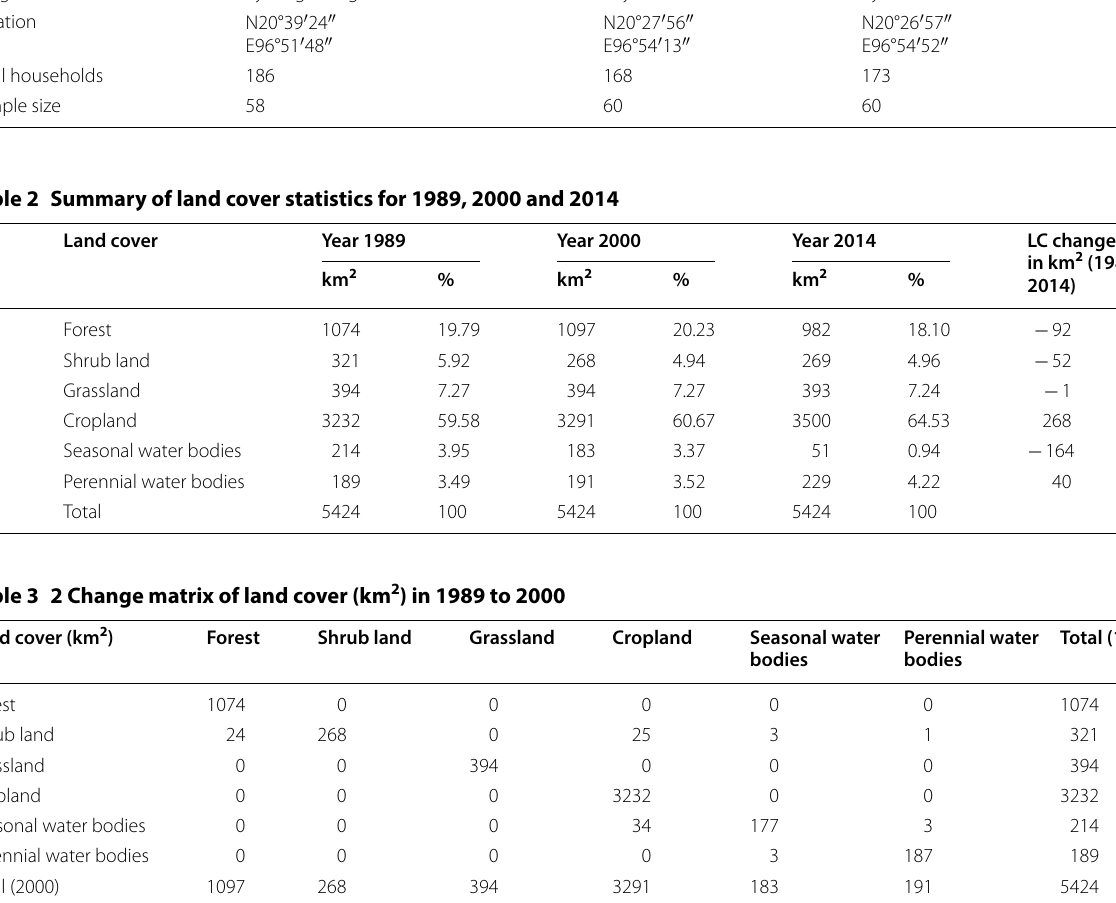
Table 1 Description of sampling areas for household survey Study area